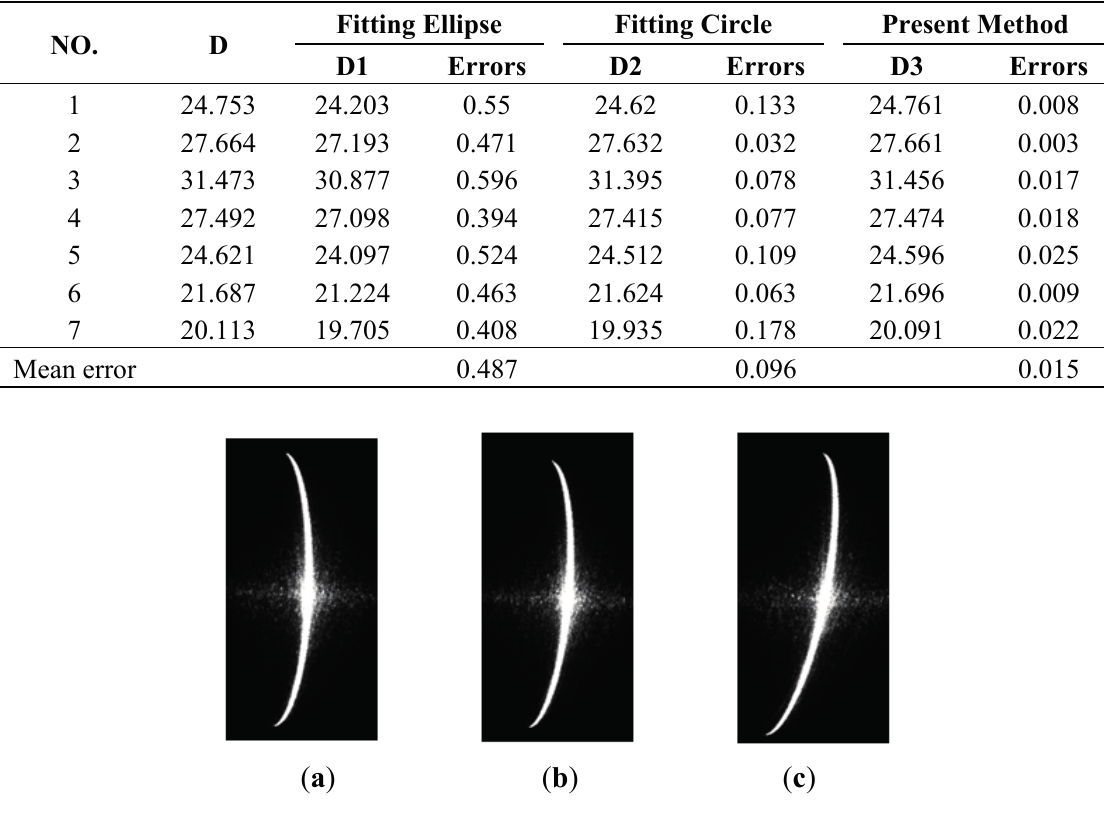
Figure 12. Images of stripes at three different angles.